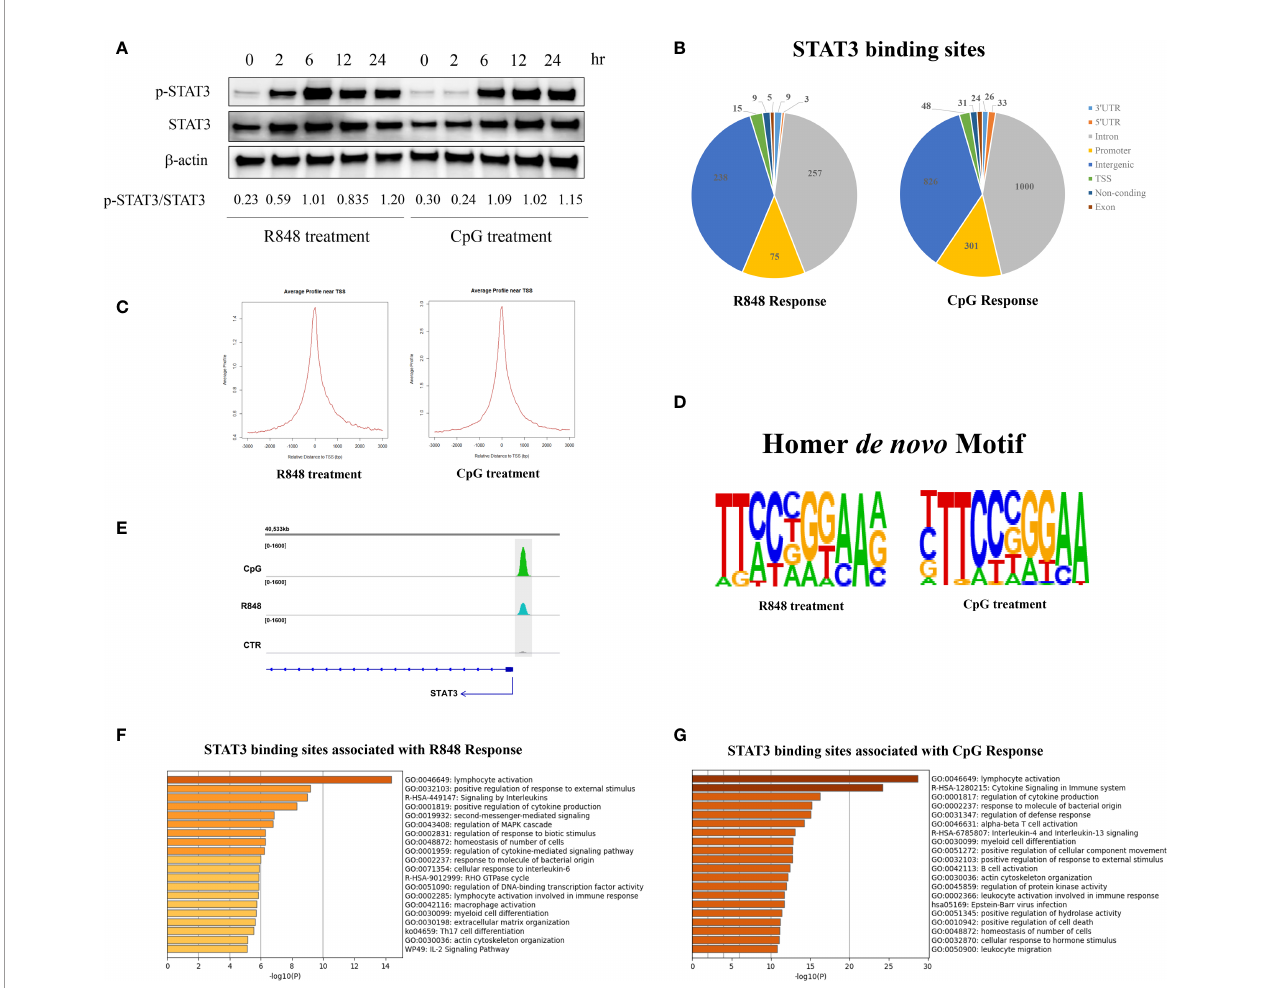
FIGURE 1 | Properties of STAT3-binding sites genome-wide. (A) Western blot showing phosphorylation of STAT3 in response to TLR7 and TLR9 stimulation. Human peripheral blood B cells were treated with TLR7 and TLR9 agonists (R848 and CpG, respectively) for different timepoints (0, 2, 6, 12, and 24 h), then western blot was used to detect the phosphorylation of STAT3 (pSTAT3, Y705-STAT3). (B) ChIP-seq was performed on untreated, R848-treated and CpG-treated puri fi ed B cells from one healthy donor. The genomic distribution (%) of the identi fi ed STAT3-binding sites after 24 h treatment of R848 and CpG in B cells. STAT3-binding sites were identi fi ed by using the MACS tool. (C) Pro fi les of STAT3 binding sites are sharply peaked near the transcriptional starting site (TSS) of genes. Left, R848 stimulated vs non-stimulated B cells; Right, CpG stimulated vs non-stimulated B cells. (D) De novo motifs for R848 response and CpG response were identi fi ed from the STAT3 ChIP-seq binding sites by using Homer de novo motif analysis. (E) STAT3 binds to its own promoter in both R848 and CpG activated human peripheral blood B cells. Functional annotation resulting from the analysis of STAT3-binding sites in R848-mediated (F) and CpG-mediated (G) response in B cells with Metascape